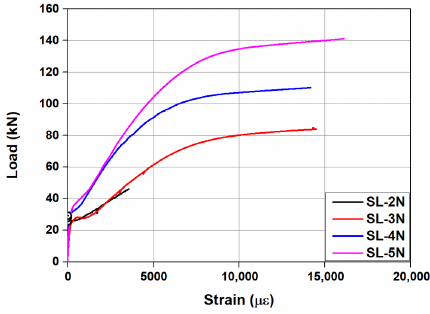
Figure 9. Comparison of load–Fe-SMA rebar strain curves of non-activated specimens according to area of Fe-SMA rebar.